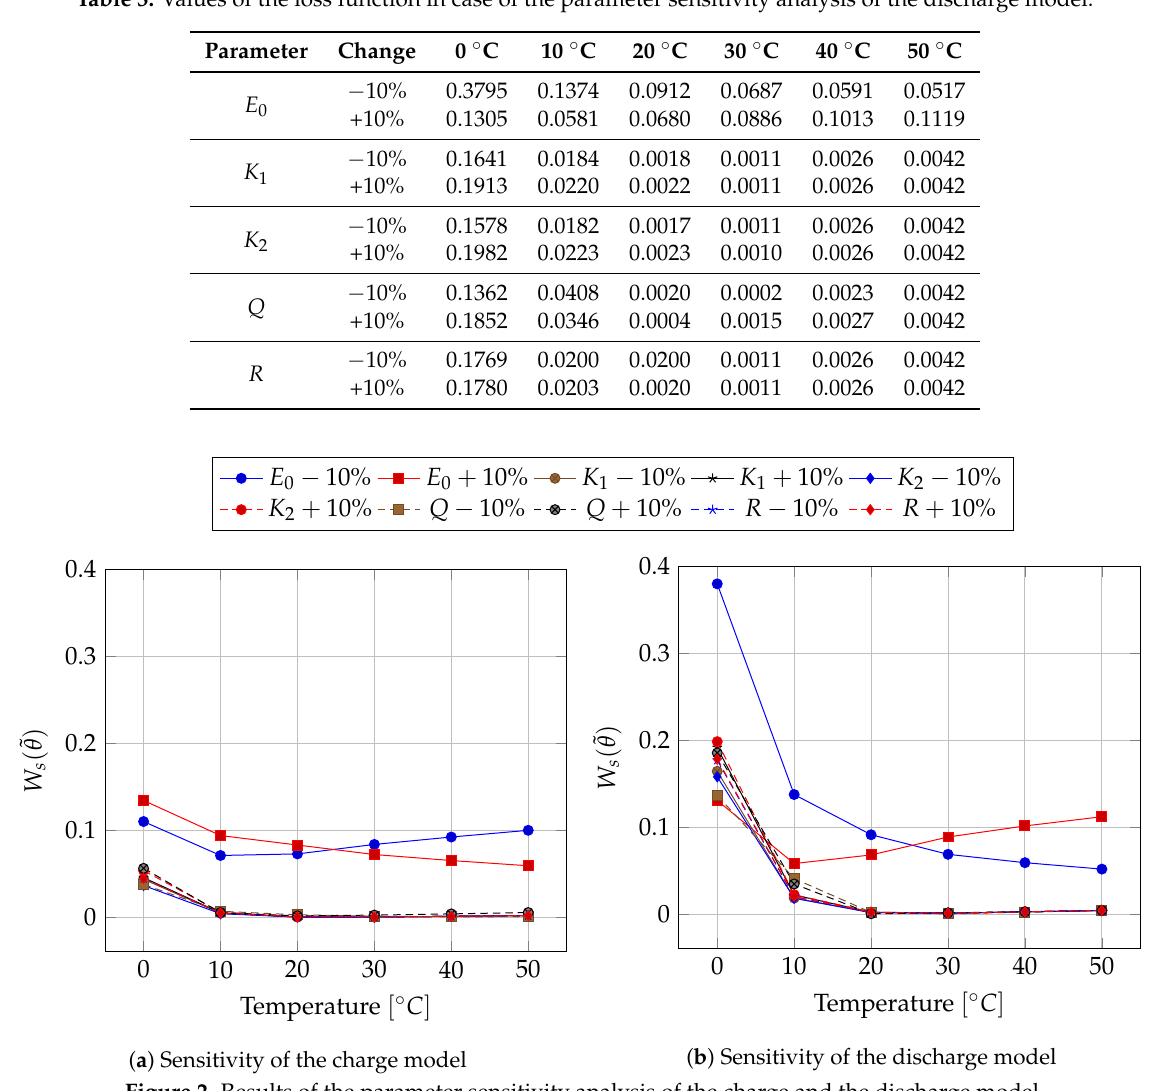
Figure 2. Results of the parameter sensitivity analysis of the charge and the discharge